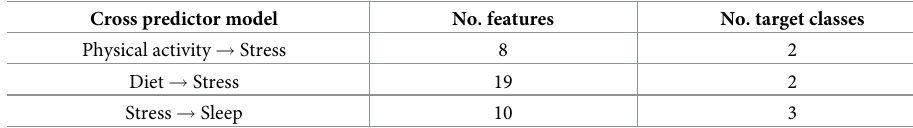
Table 3. Number of features and target classes for each predictive